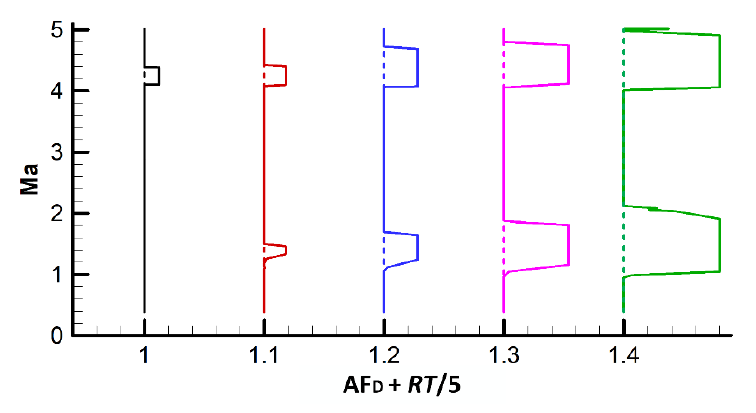
Figure 13. Rocket RT profiles at different AF D (Isp = 300 s).